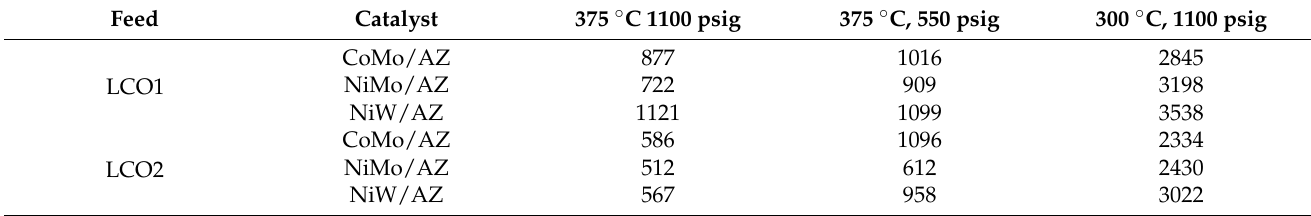
Table 5. Sulfur content (ppm)in the final products with different LCO feed.